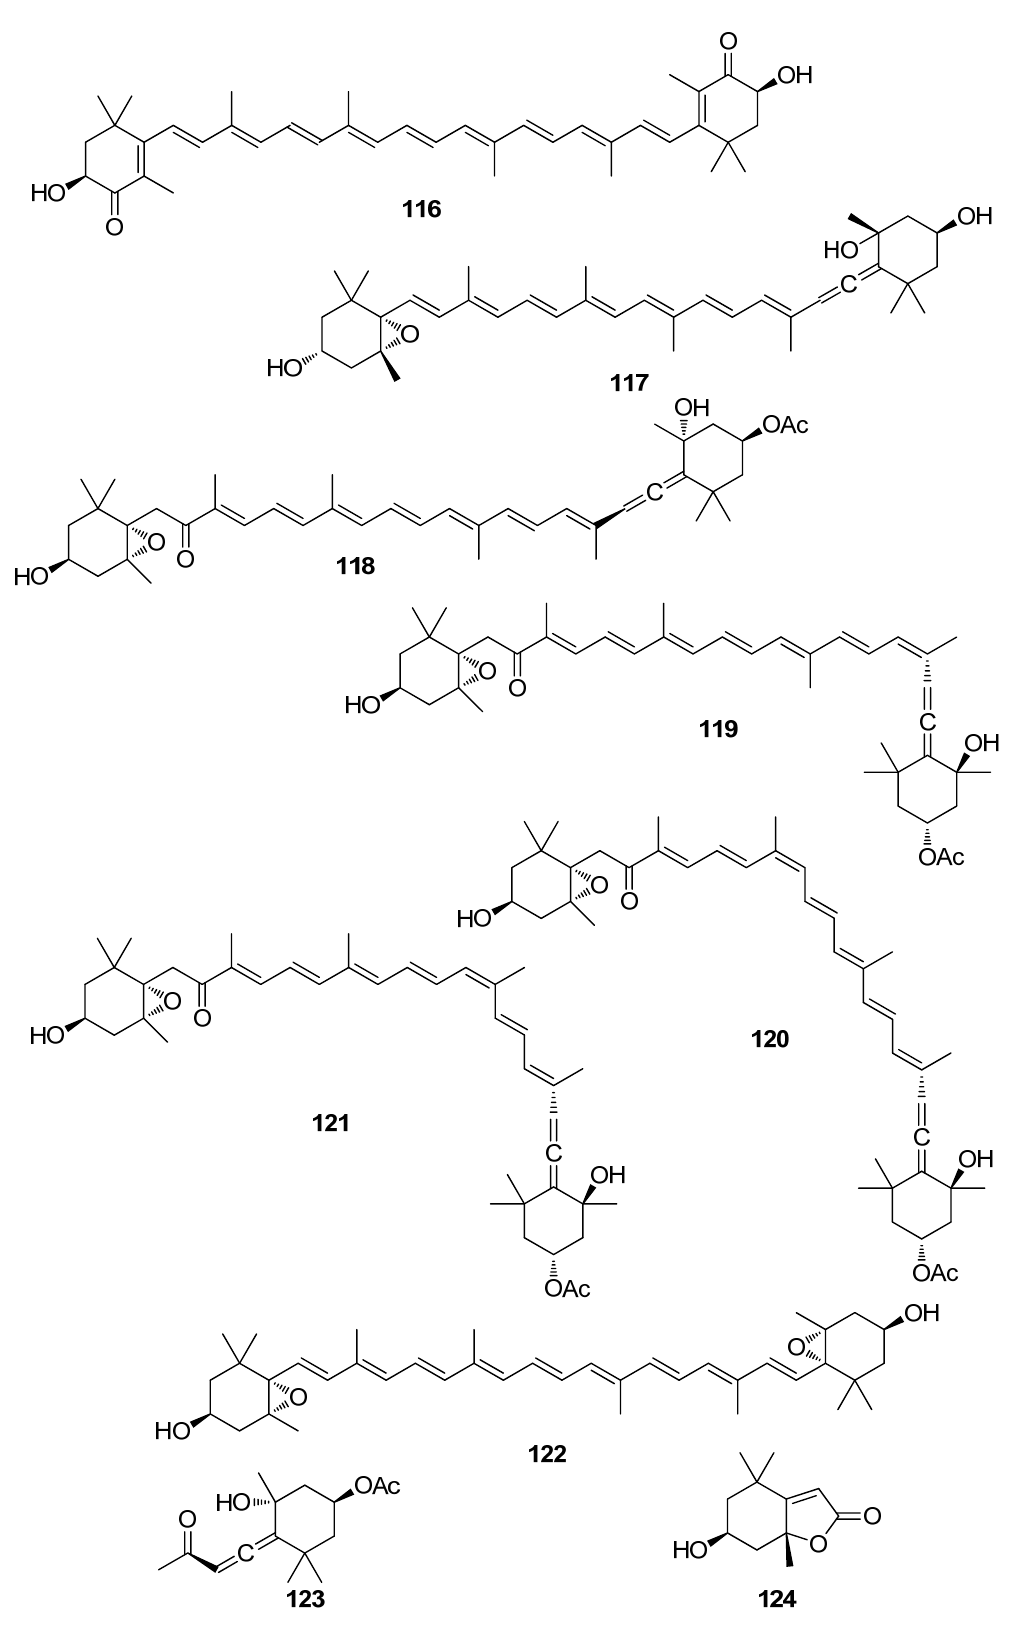
Figure 12. Chemical structures of compounds 116 – 124 .